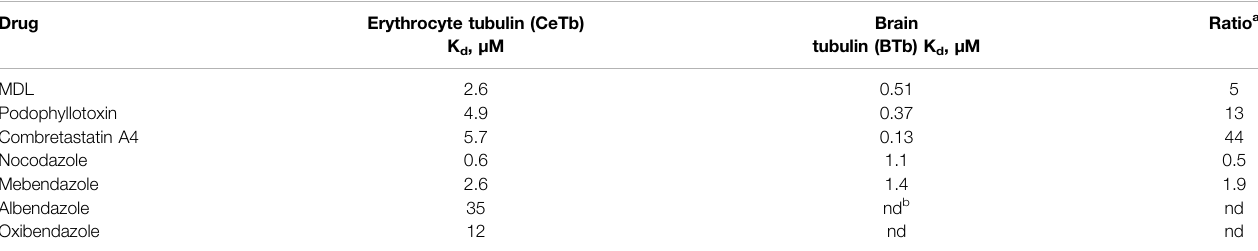
a The last column ( “ Ratio ” ) shows the K d of the drug and CeTb divided by the K d of the drug and BBTb. b nd, not determined.